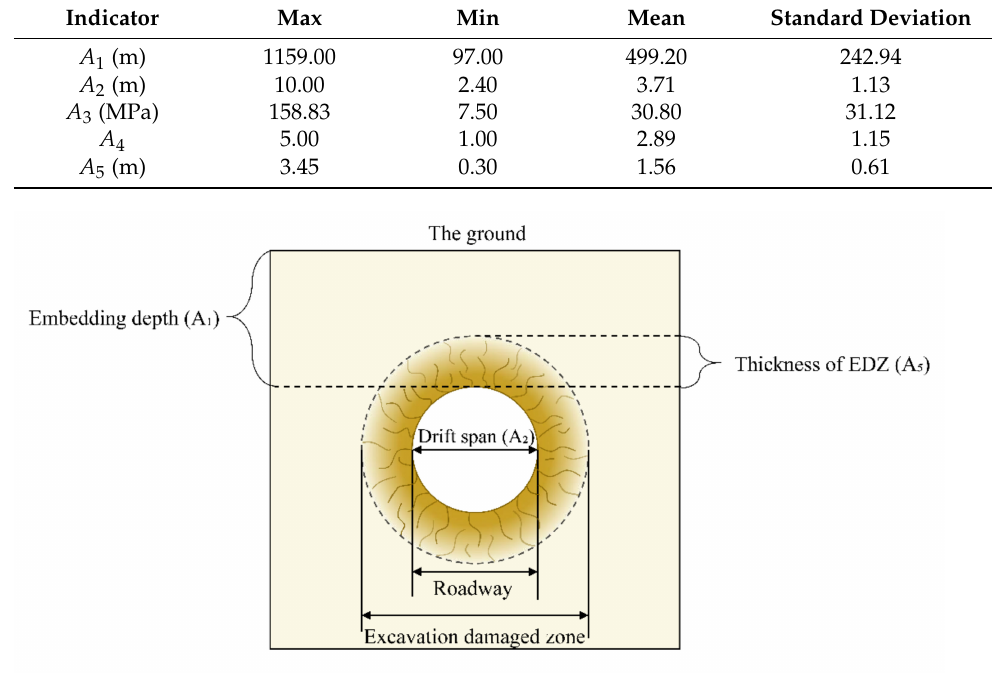
Figure 2. Excavation damaged zone around the roadway. Table 2. Meanings of these indicators. Indicator Meaning Indicates the depth of the roadway from the